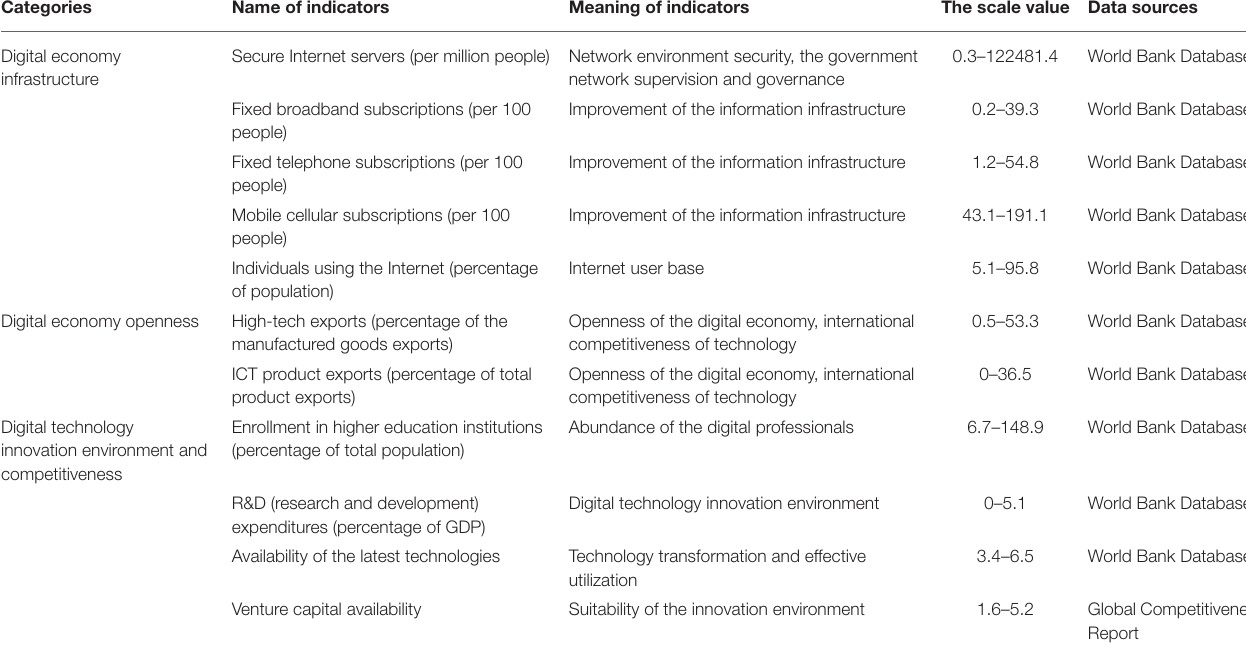
TABLE 1 | Comprehensive evaluation index system of digital economic development.